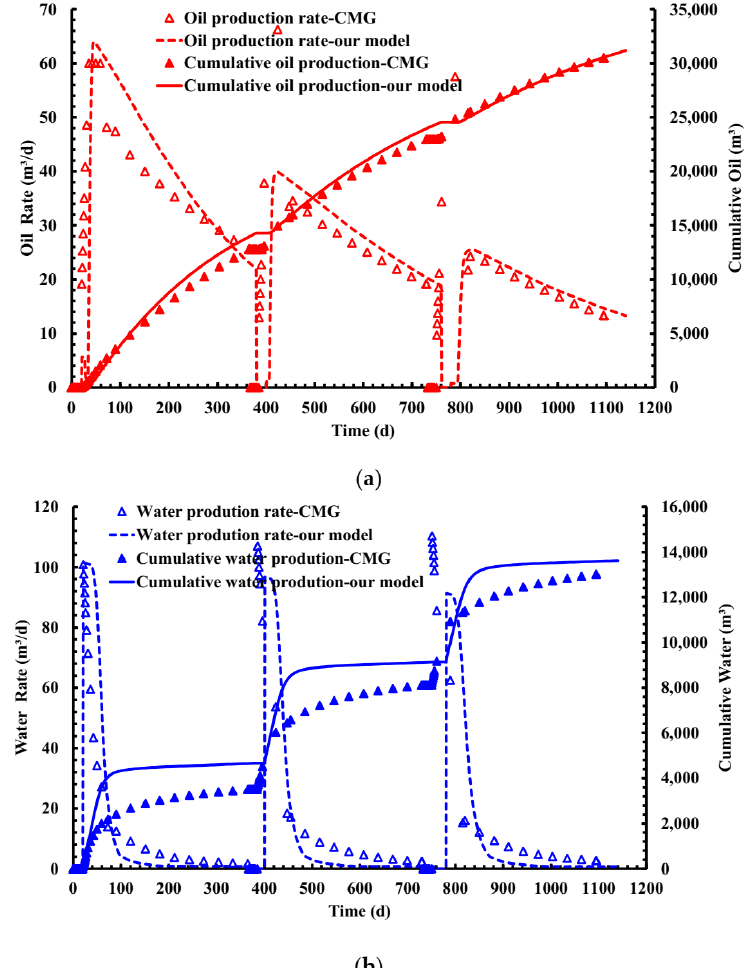
Figure 6. Simulation results—( a ) Oil production rate and cumulative oil production; ( b ) Water production rate and cumulation water